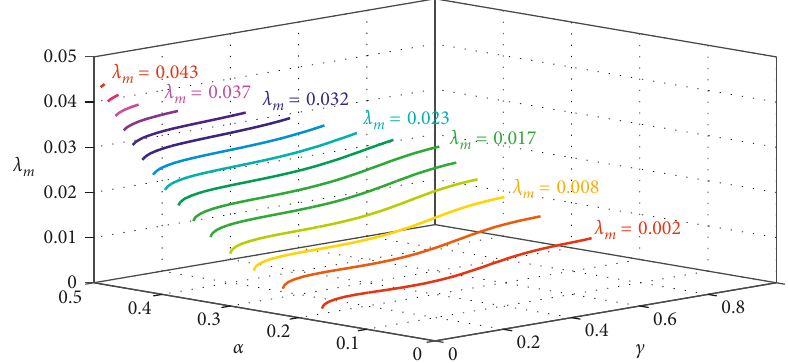
c for constant λ m values.